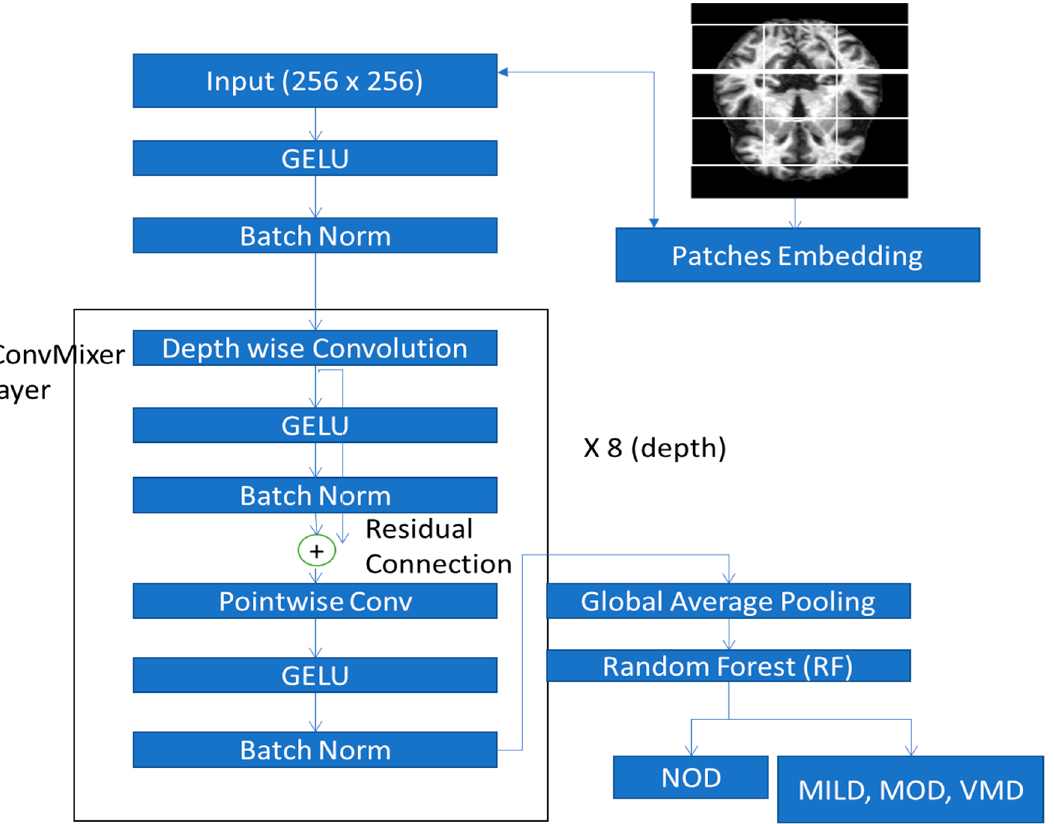
Figure 5. The proposed ConvMixer model architecture to integrate blockwise fine-tune strategy.